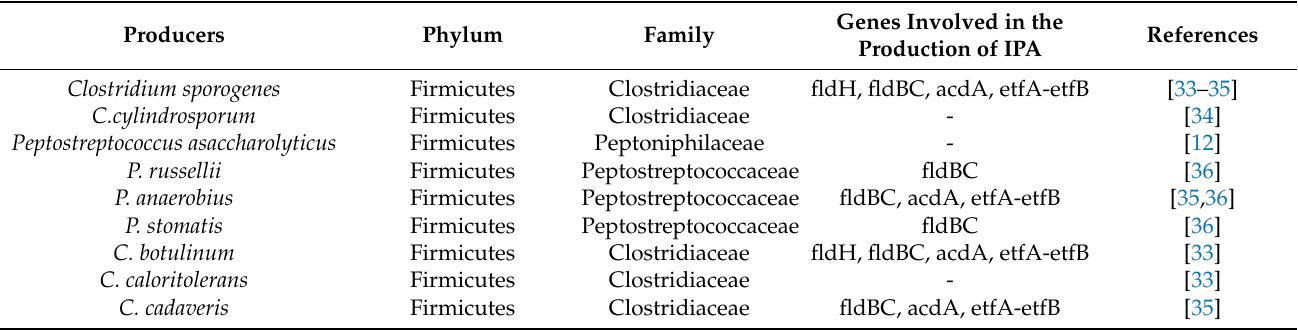
Table 1. Gut bacterial species reported to produce IPA.